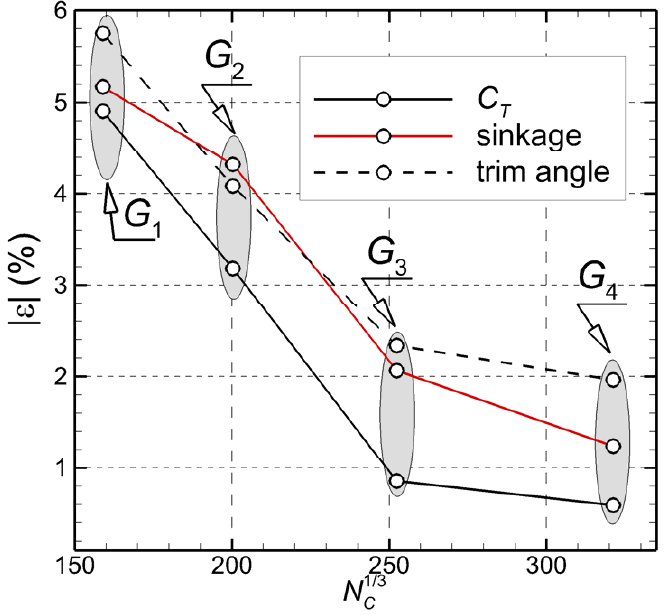
Figure 3. Grid convergence test.